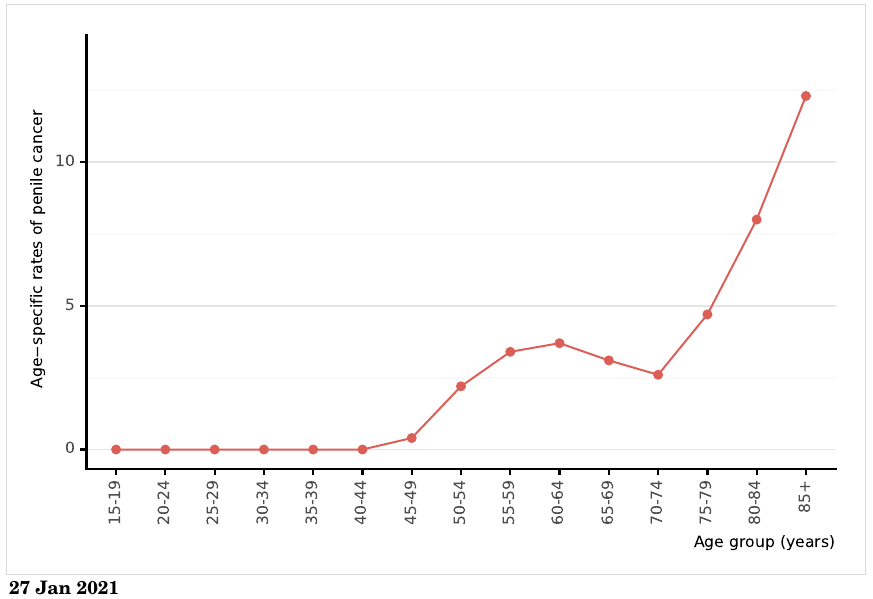
Figure 33: Age-specific mortality rates of penile cancer in India (estimates for 2020)